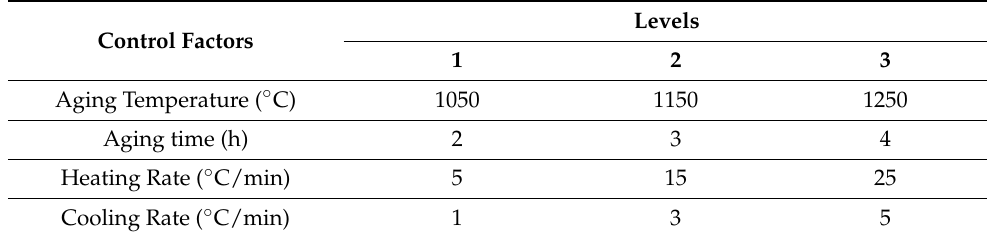
Table 6. L 9 Orthogonal Array.